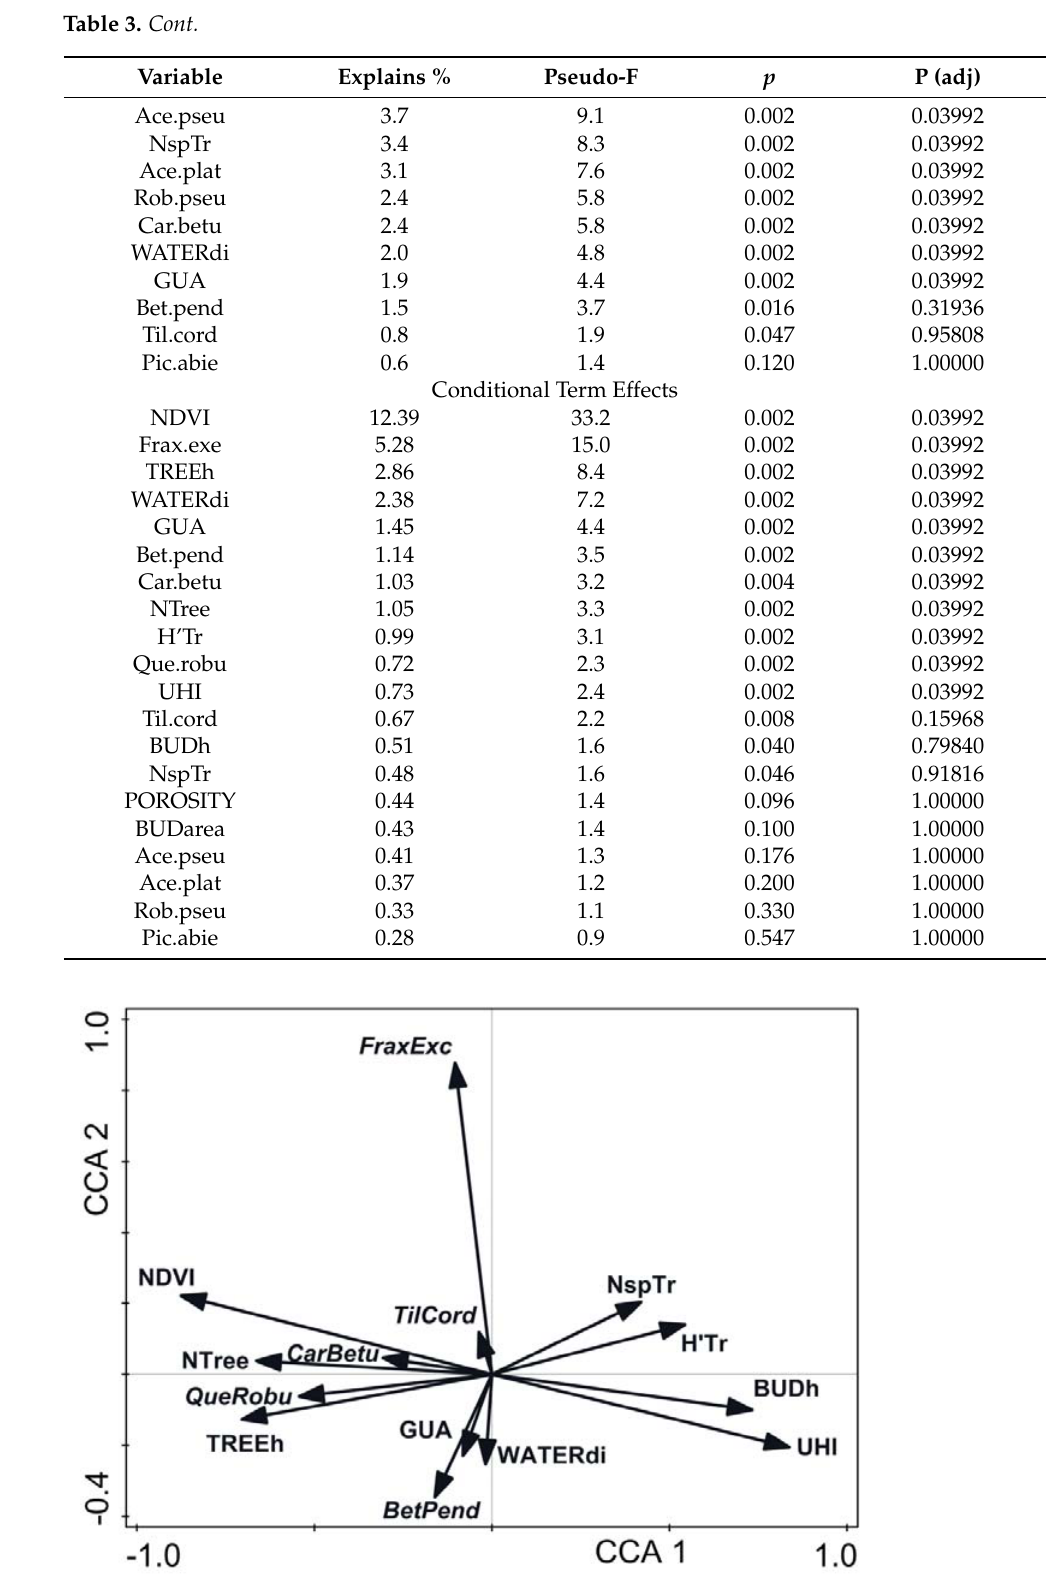
Figure 4. CCA environmental variables ordination. For abbreviations of variables see Table 2. Labels in italics denote tree species names: Fraxinus excelsior , Tilia cordata , Carpinus betulus , Quercus robur , and Betula pendula .